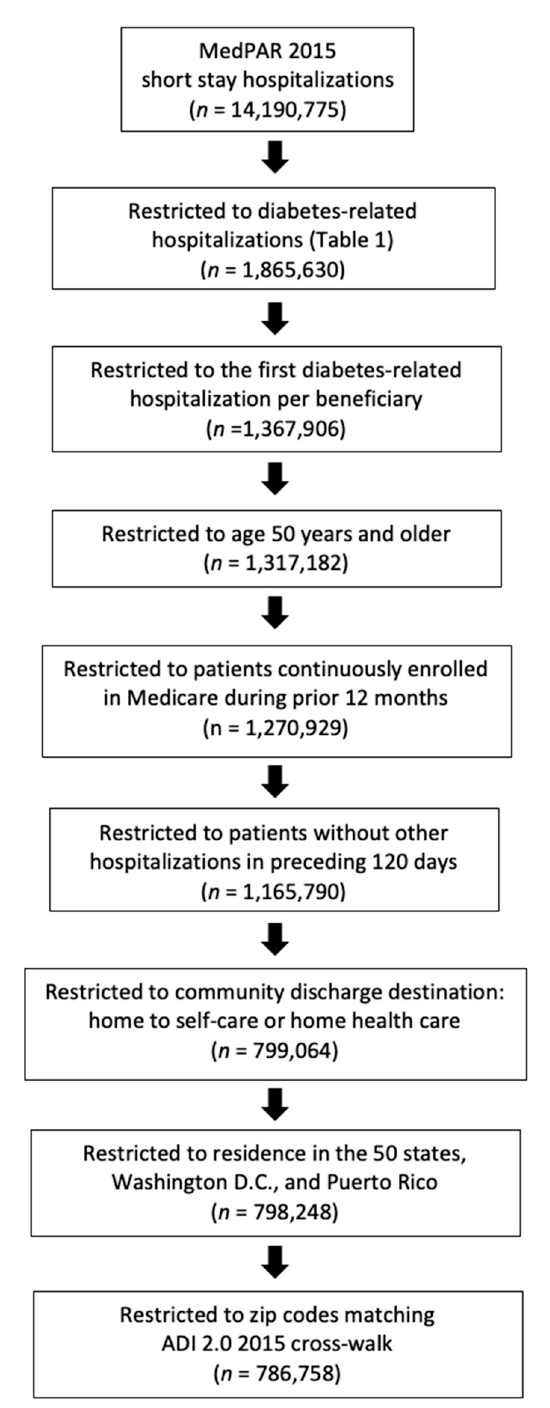
Figure 1. Delimitation of index hospitalizations and study sample. Table 1. International Classification of Diseases (ICD) Codes Used to Identify Diabetes-Related Hospitalizations